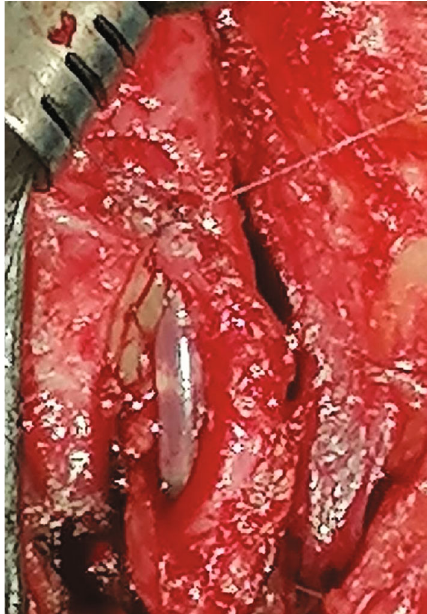
Figure 11: RUG in the left oblique view 4 weeks posturethroplasty showing normal caliber anterior urethra with no contrast